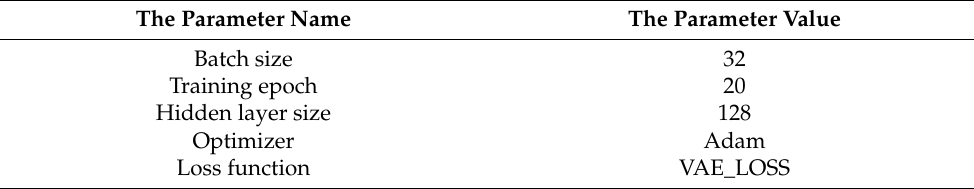
Table 2. Variational auto-encoder network’s training